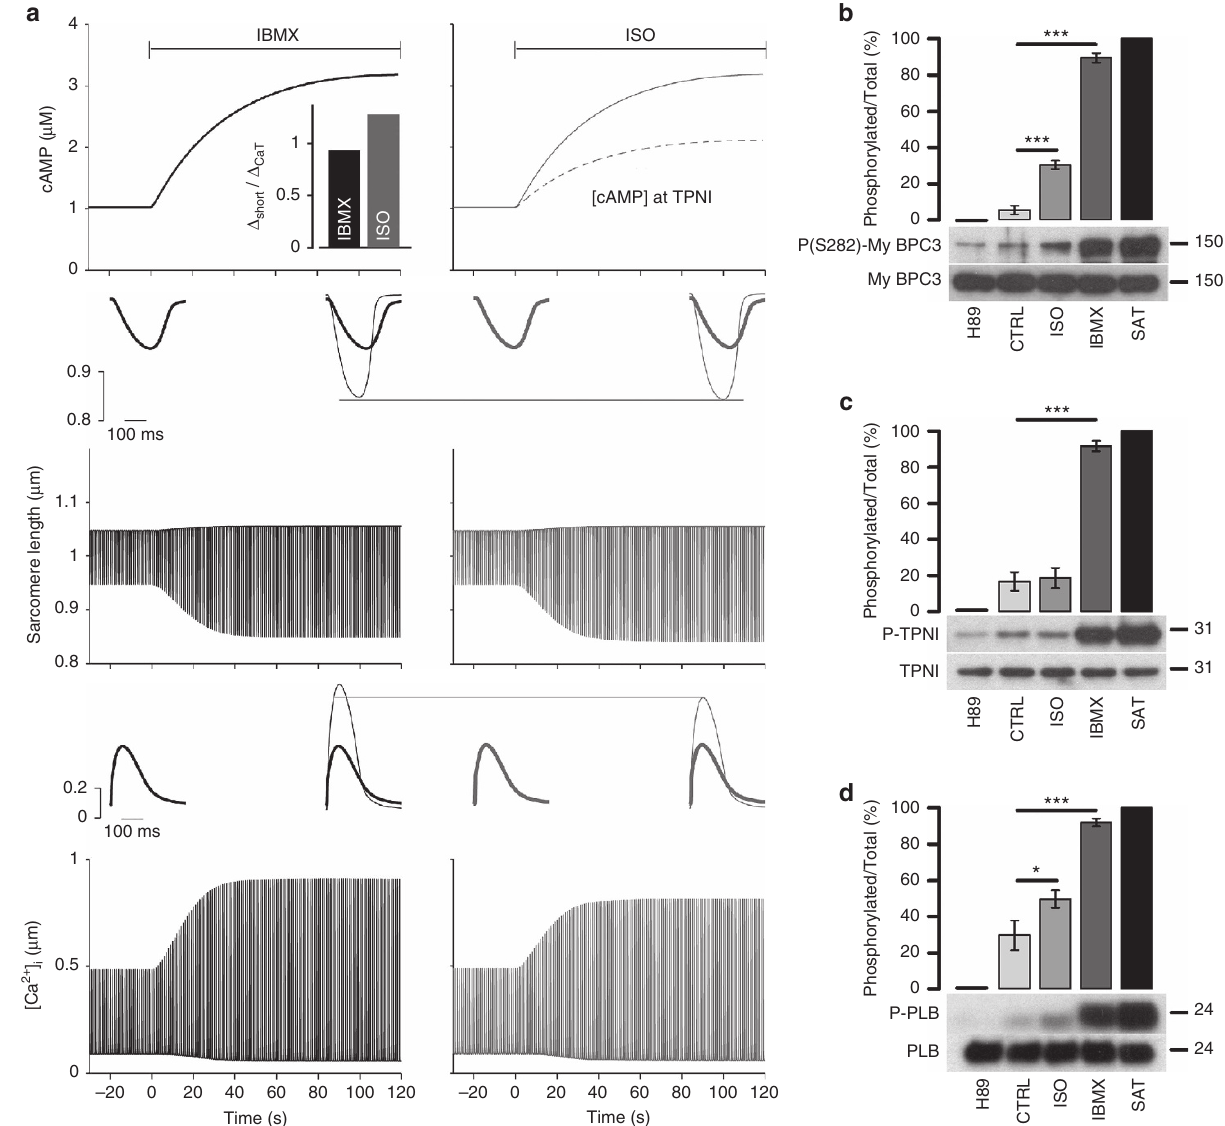
Figure 5 | Mathematical model of compartmentalized cAMP signalling. ( a ) Simulated cAMP rise (top), myocyte shortening (middle) and Ca 2 þ transient (bottom) upon administration of IBMX or ISO at time ¼ 0s. Inset at the left shows baseline condition, and inset at right shows overlapping baseline condition (grey) and steady-state response to cAMP increase. Bar graph in a shows the ratio of the increase in maximal shortening to increase in Ca 2 þ transient amplitude induced by IBMX and ISO. ( b ) Western blotting analysis of cell lysates obtained from ARVM treated with H89 (30 m M), vehicle